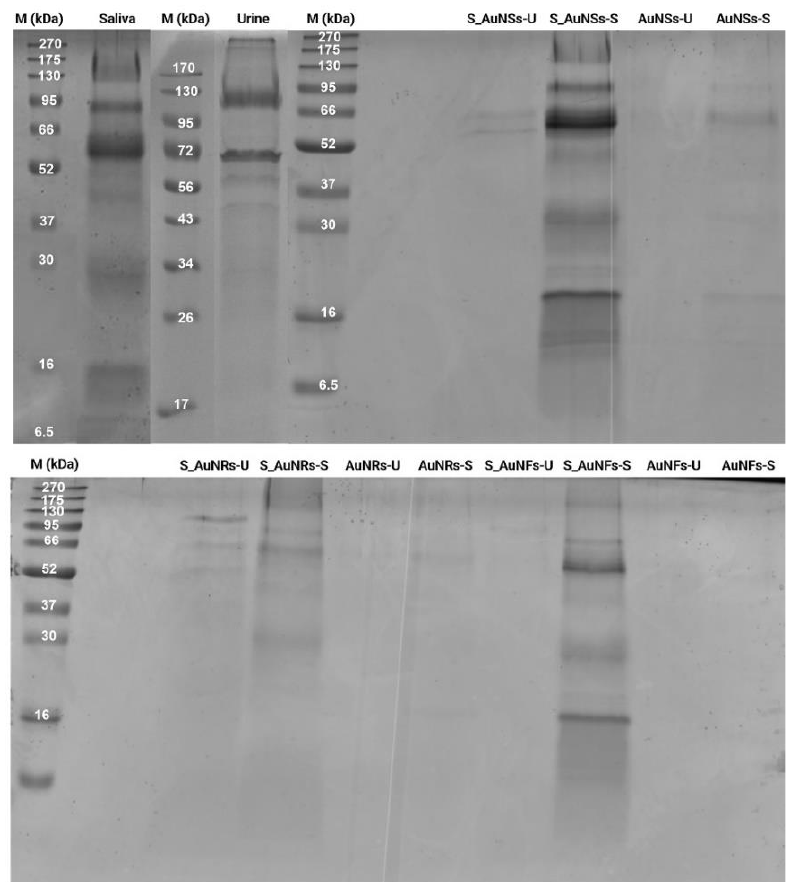
Figure 6. SDS-PAGE (12%) gel achieved after the incubation of AuNSs, AuNRs, and AuNFs incu- bated with urine (U) or saliva (S). M: Marker; Control: Diluted saliva used as reference; S: Supernatant of AuNPs.